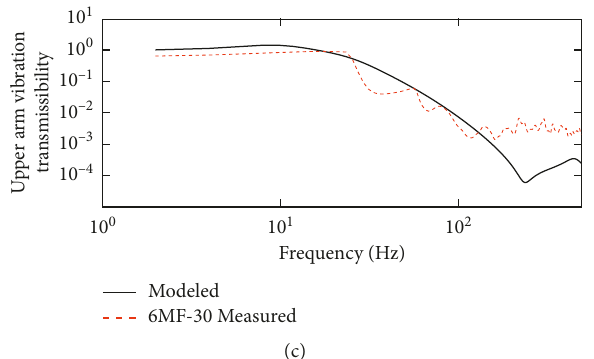
Figure 5: The VTs for different sets of (a) wrist, (b) forearm, and (c) upper arm.